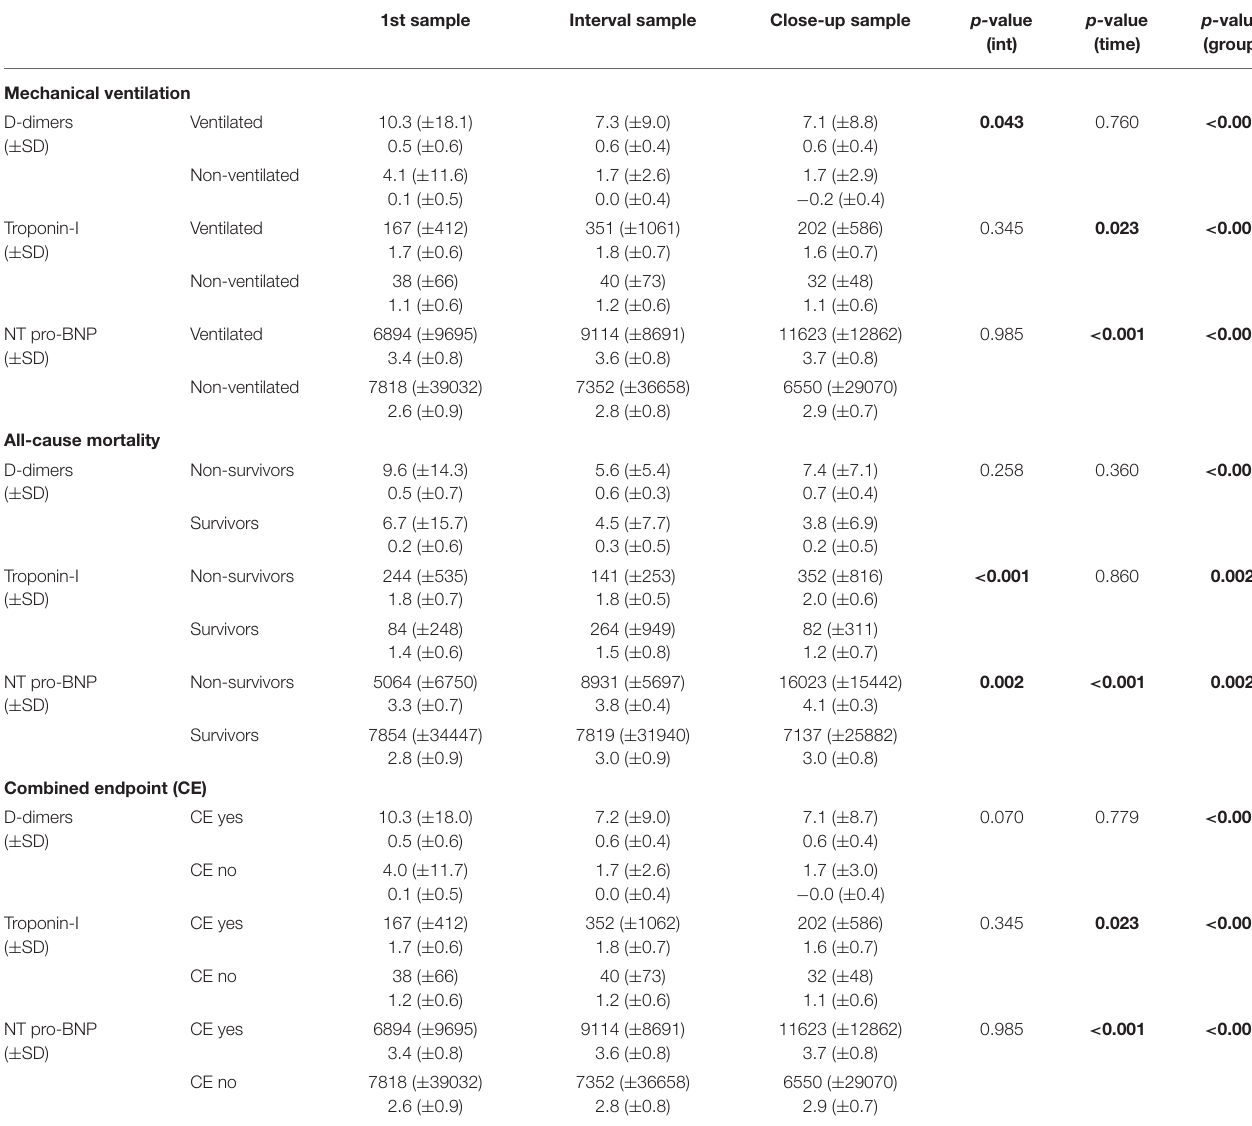
TABLE 4 | D-dimer, troponin-I, and NT-pro-BNP levels at admission (1st sample), median of hospital stay (interval sample), and discharge/death (close-up sample) stratified according to mechanical ventilation, all-cause mortality, and the combined